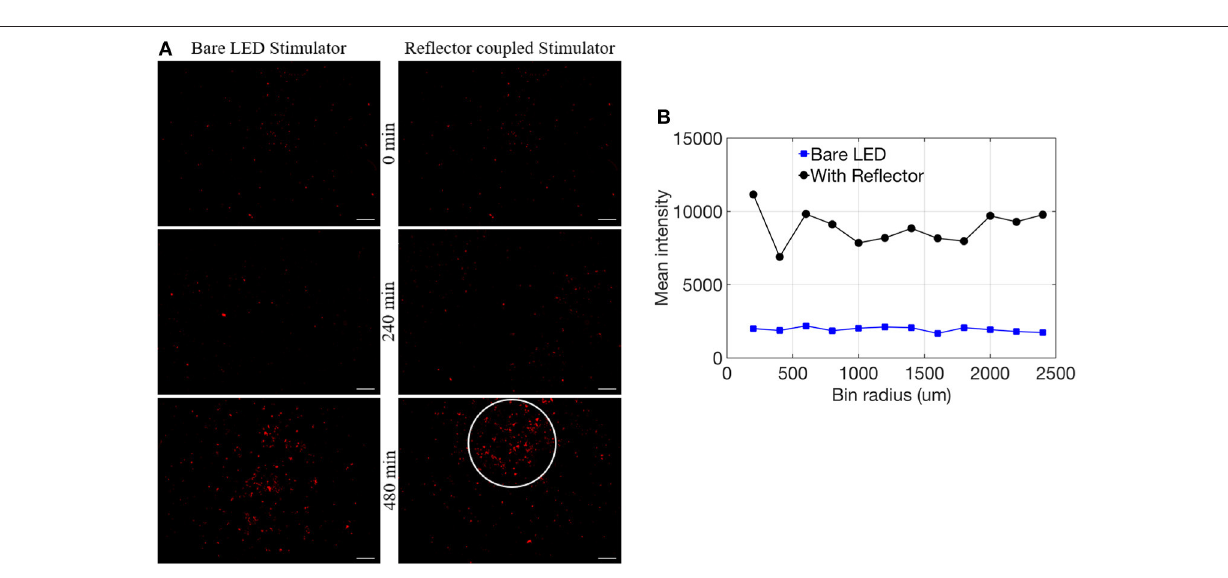
exposure duration of 480 min. As expected, light-stimulated